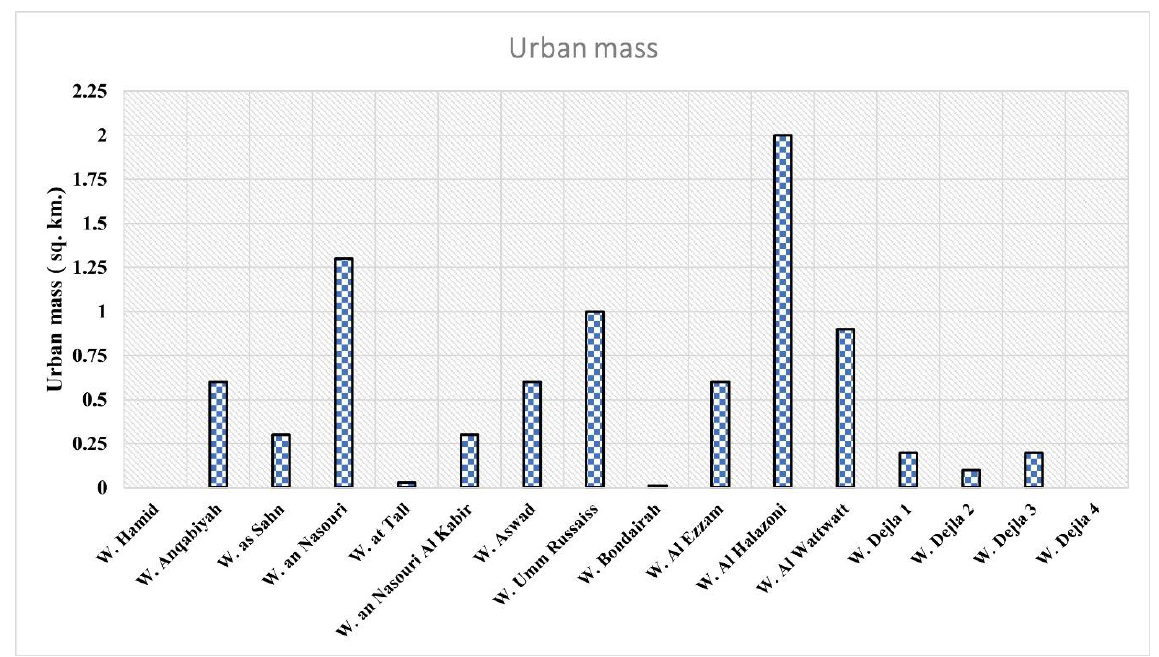
Figure 15. Urban mass that is under threat of flash flood hazards within the watersheds in the study area east of Cairo.